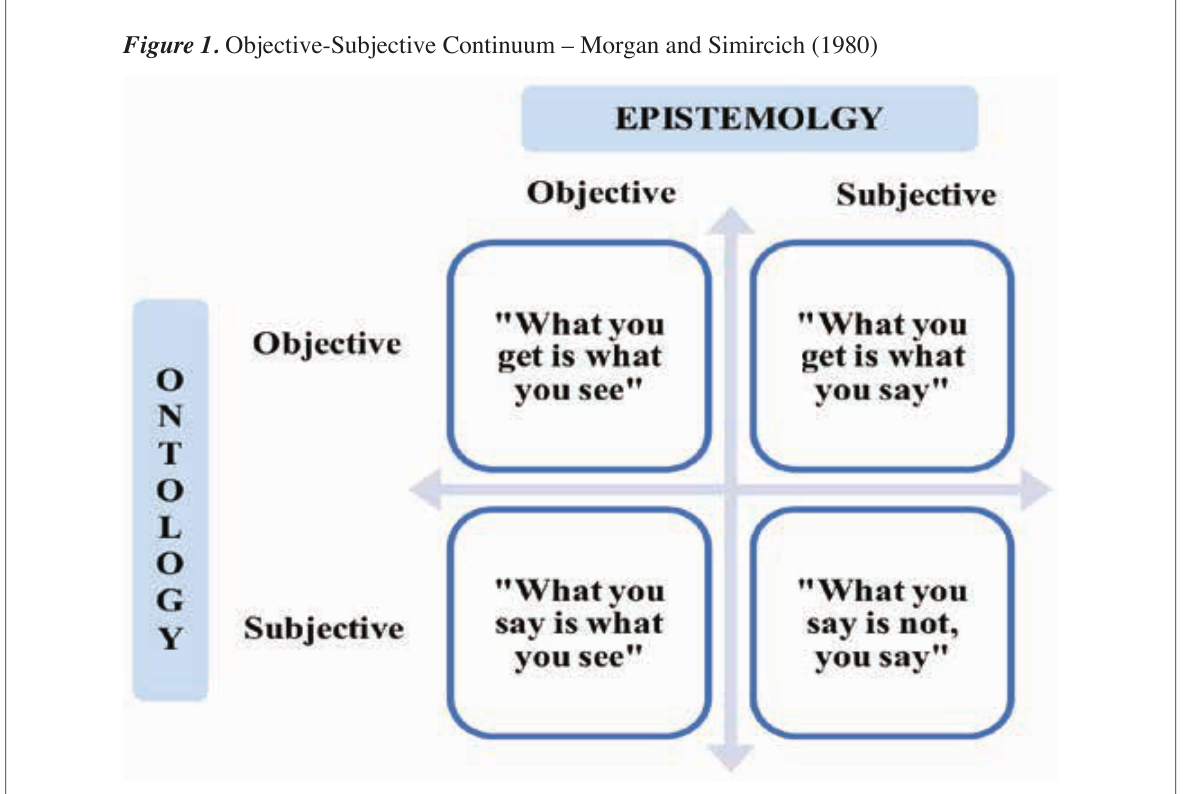
Figure 1. Objective-Subjective Continuum – Morgan and Simircich